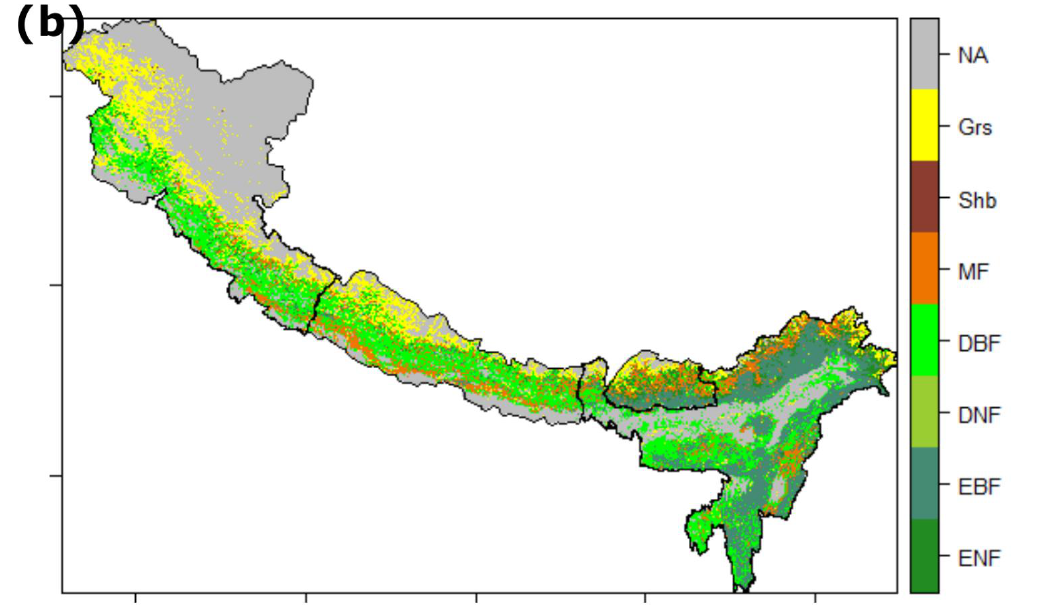
Figure 1. Elevation over study area including Western Himalaya, Nepal, Bhutan, and Eastern Himalaya ( a ) (Data source: Advanced Land Observation Satellite World 3D (30 m) digital surface model (DSM) and MODIS-derived forest cover map for 2010 ( b ); ENF: evergreen needleleaf forest, EBF: evergreen broadleaf forest, DNF: deciduous needleleaf forest, DBF: deciduous broadleaf forest, MF: mixed forest, Shb: shrubland, and Grs: grassland.